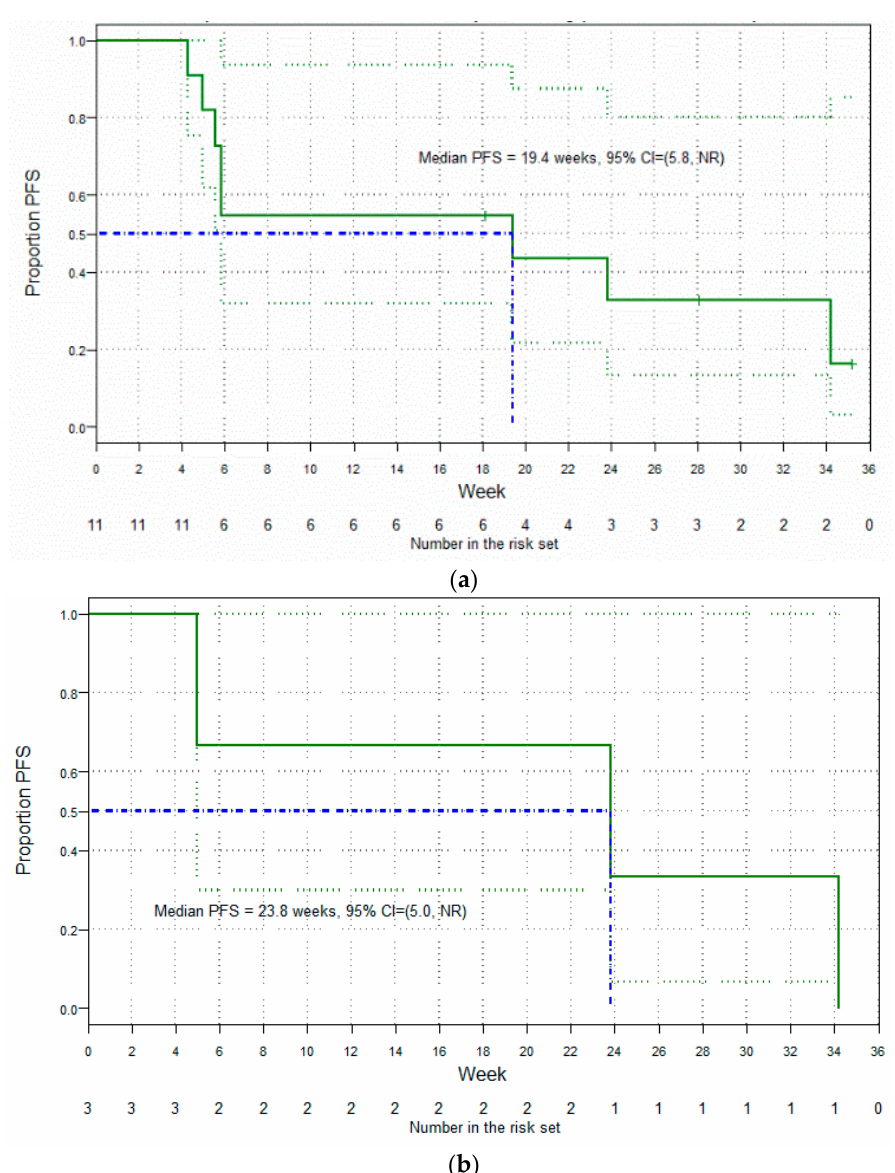
Figure 6. Post-hoc analysis of the antitumor activity of Cantrixil: ( a ) Kaplan–Meier survival curve in the efficacy-evaluable population, minus patients with platinum-sensitive disease (Patients who were unable to receive further platinum-based chemotherapy due to documented intolerance); ( b ) Kaplan–Meier survival curve in patients with platinum-refractory disease.